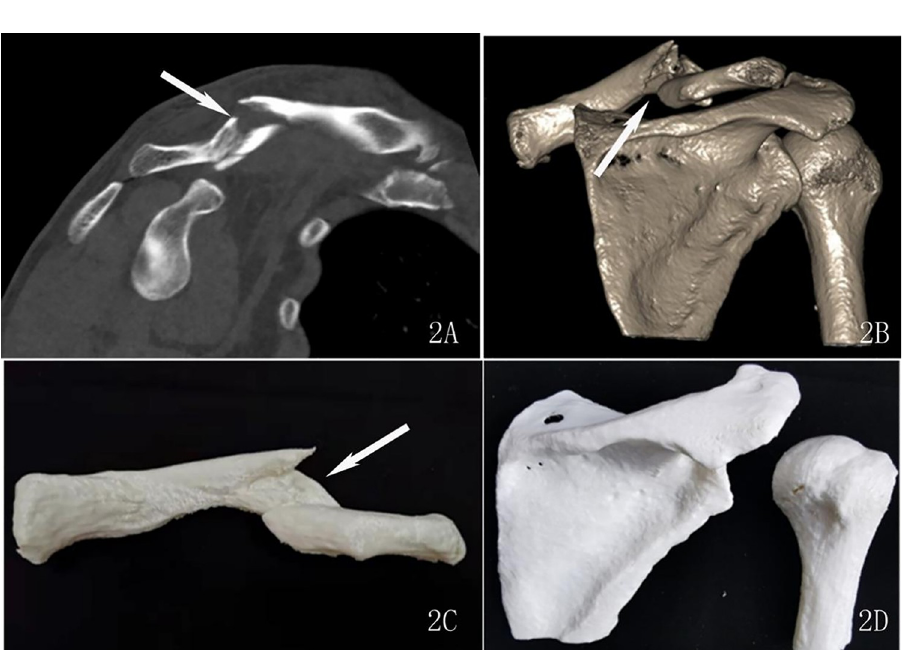
Fig 2. A 49-year-old man with a left clavicle fracture underwent a low-dose CT scan. 2A: oblique coronal reconstruction images show the fracture line (arrow), scored 3 points. 2B: Three-dimension reconstruction images show the fracture lines (arrow), scored 3 points. 2C and 2D: Three-dimension printed models of the clavicle and the scapula and humerus, respectively, scored 3 points.